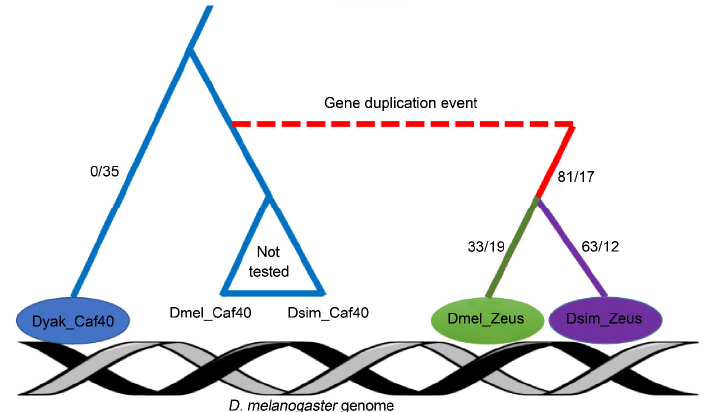
Figure 1. Design and results of ChIP-Seq experiments. Depiction of Zeus/Caf40 phylogeny, with experimental design. Zeus originated from a gene duplication event 4–6 million years ago, before the split of D. melanogaster and D. yakuba . We sampled two copies of Zeus ( D. melanogaster and D. simulans ), as well as a single copy of Caf40 from D. yakuba , which represents the ancestral pre-duplication state of the protein. All three proteins were introduced into the D. melanogaster genome with 3x FLAG tags attached in order to eliminate problems with variable antibody affinity. Numbers indicate the volume of nonsynonymous (before the slash) and synonymous (after the slash) changes.